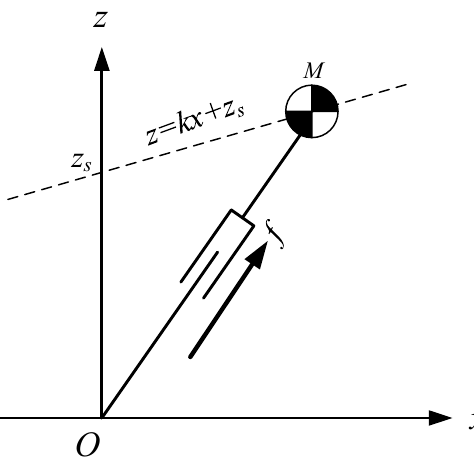
Figure 2. LIPM-CoM moving along a constraint line.